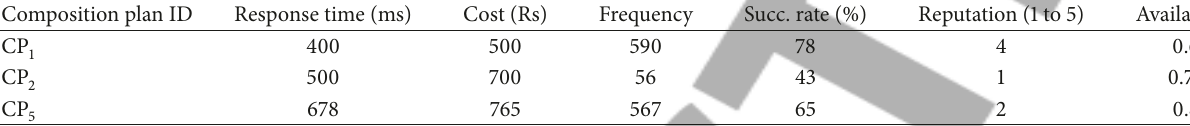
Table 4: Example of Pareto optimal based